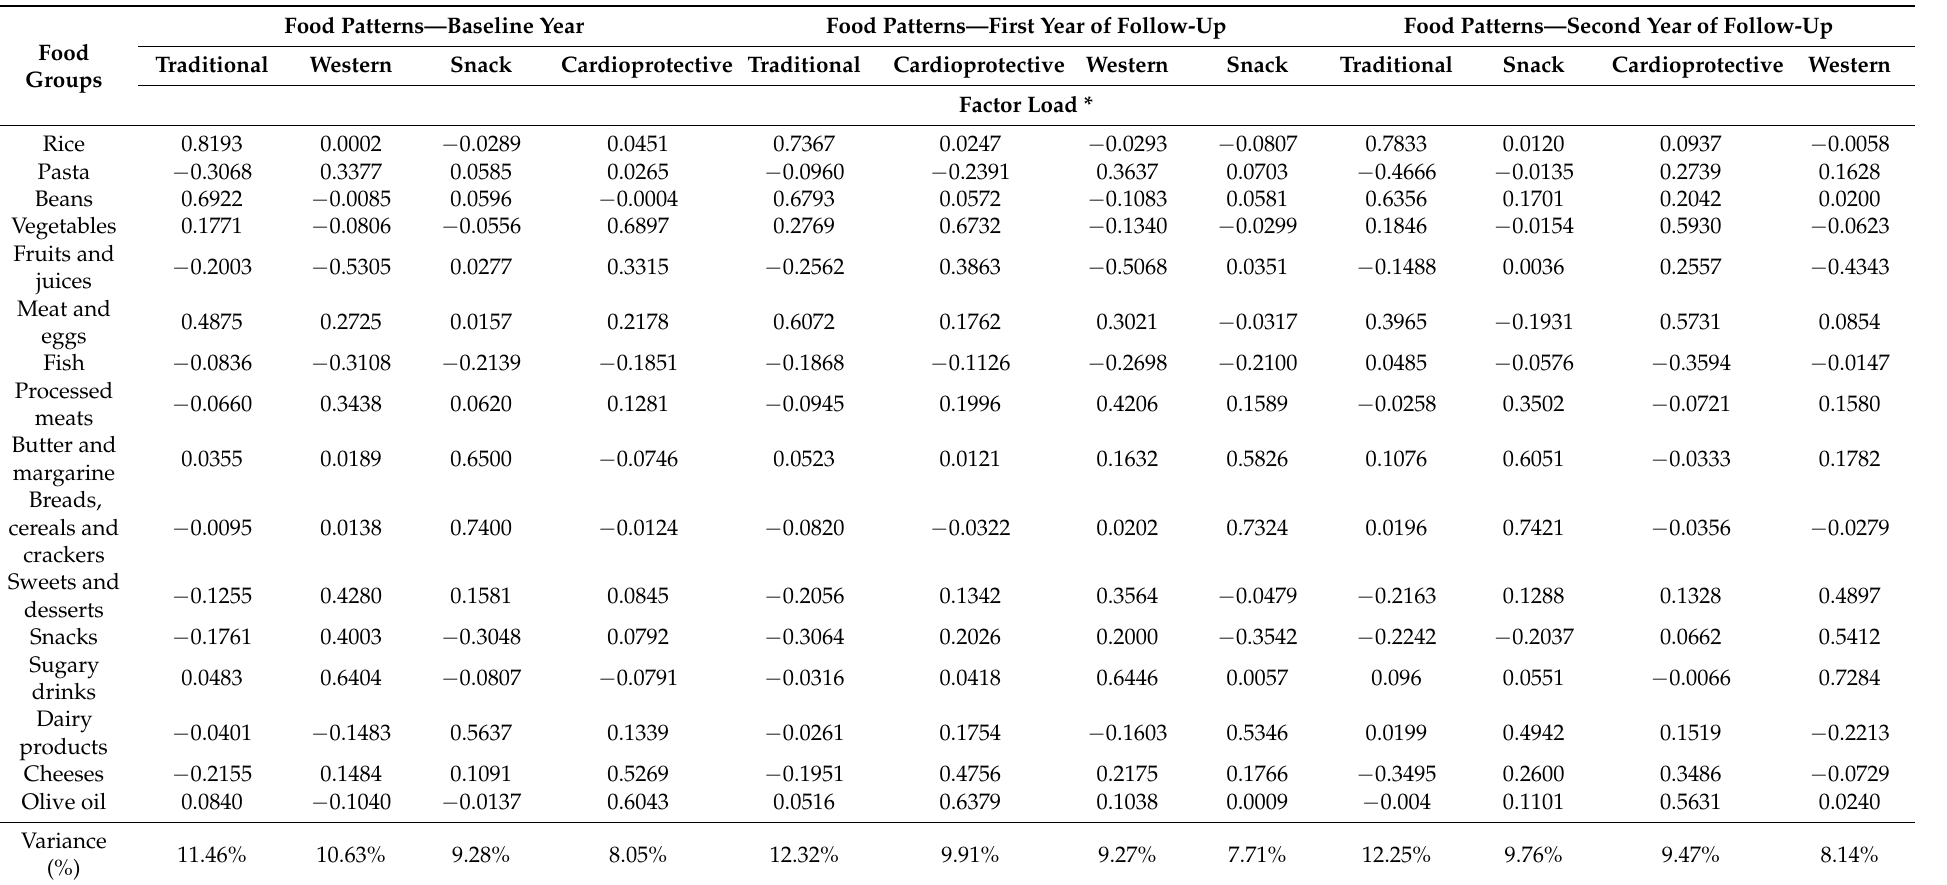
Table 3. Food patterns and factor loads of food groups extracted from the factor analysis with the principal component extraction method for individuals of the BALANCE program’s intervention group.